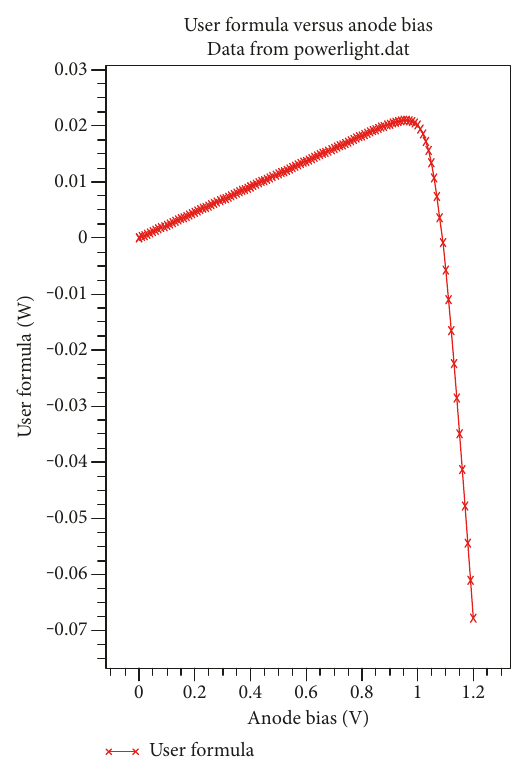
User formula versus anode bias Data from powerlight.dat